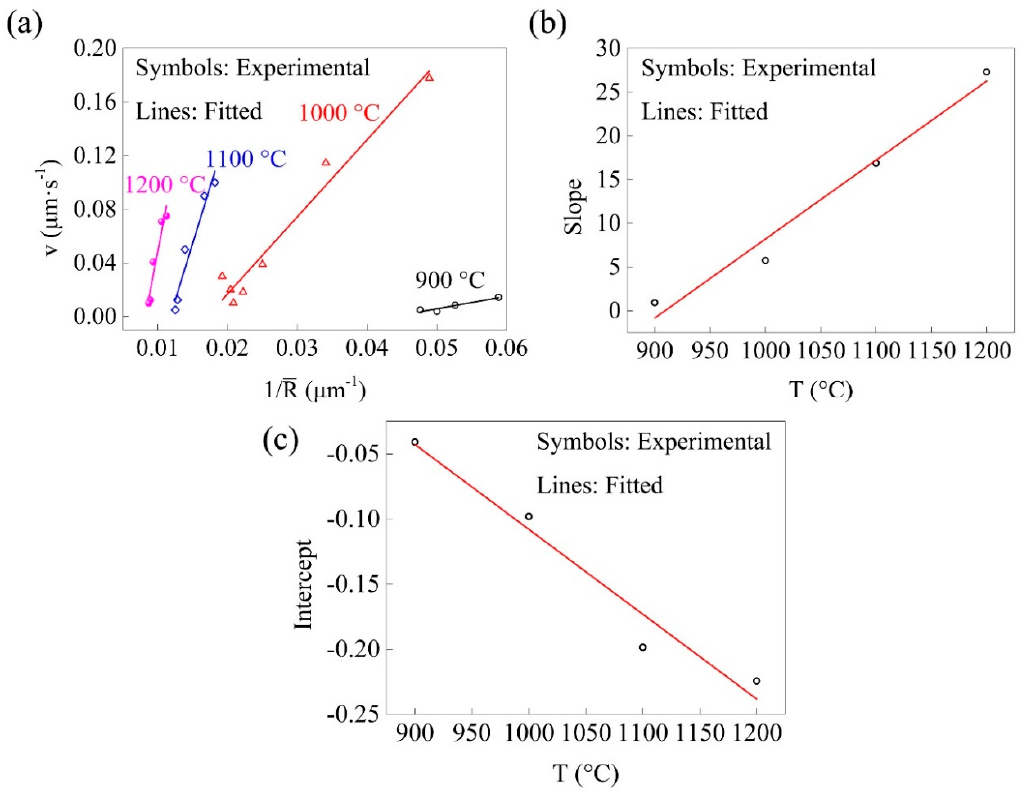
Figure 13b. The mean relative error was calculated to be 5.36%, and the R value for evaluating the goodness of fitting was 0.995, indicating that the model was precise. For comparison, the Burke and Turnbull model [24] was also implemented, and the mean relative error was calculated to be 11.2%, showing that the model established in this investigation was more accurate. Materials 2018 , 11 , x FOR PEER REVIEW